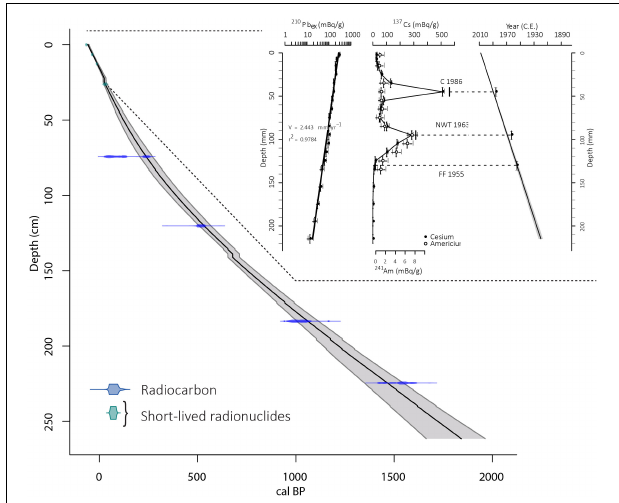
FIGURE 4 | Age-depth model based on radiocarbon (blue) and short-lived radionuclides (green) for the entire AIG16-MC sediment sequence. The age-depth model based on radionuclides is derived from serac package with from left to right: 210 Pbex, 137 Cs and 241 Am activities and CFCS age model.